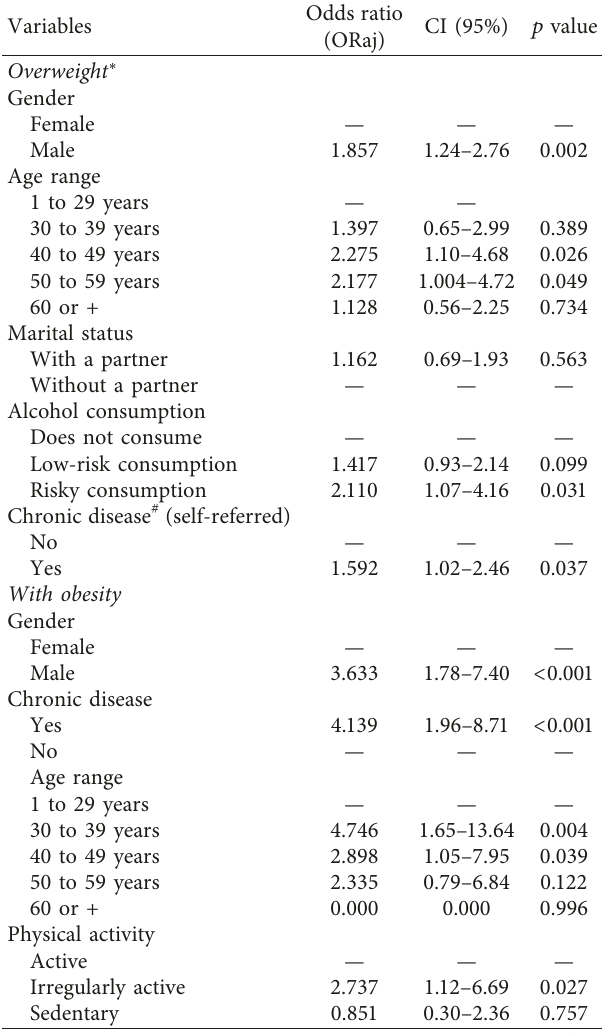
Table 3: Logistic regression of factors associated with overweight and obesity in Japanese-Brazilians living in Maring´a-PR, Brazil,